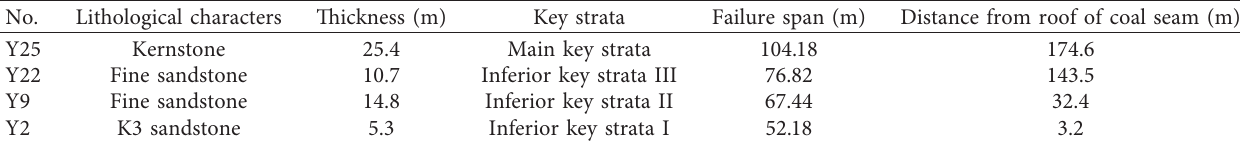
Figure 1: Judgment flow chart for height of fractured zone. Table 2: Identification results of key strata.